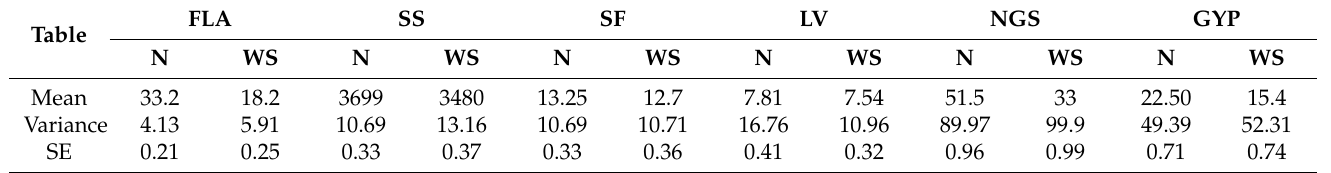
Table 2. Summary statistics of studied attributes under both conditions based on data averaged over years. Table